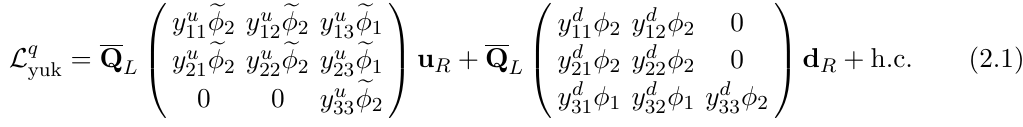
symmetry breaking could be several B (cid:0) L